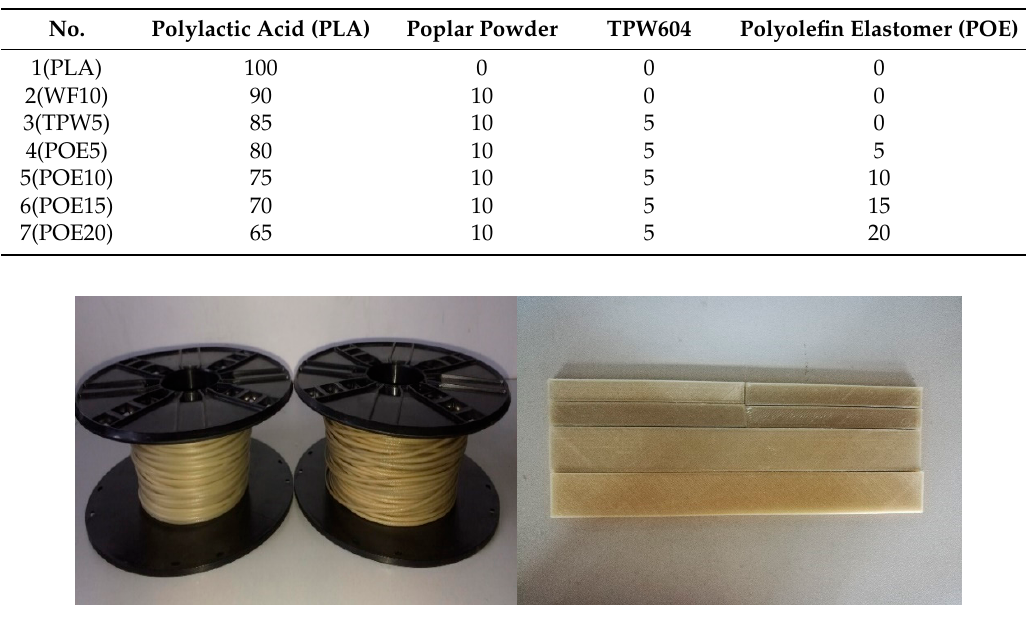
Figure 1. Filamentary three dimensional (3D) printing materials samples and three-dimensional printing plate.